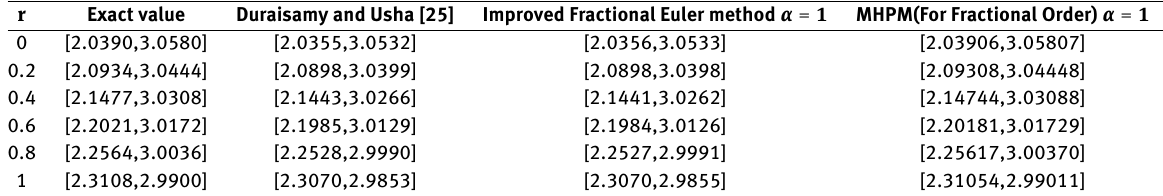
Table 3. Solutions obtained by exact method, Duraisamy and Usha [25], MHPM and IFEM for h = 0.1 at t = 1 . r